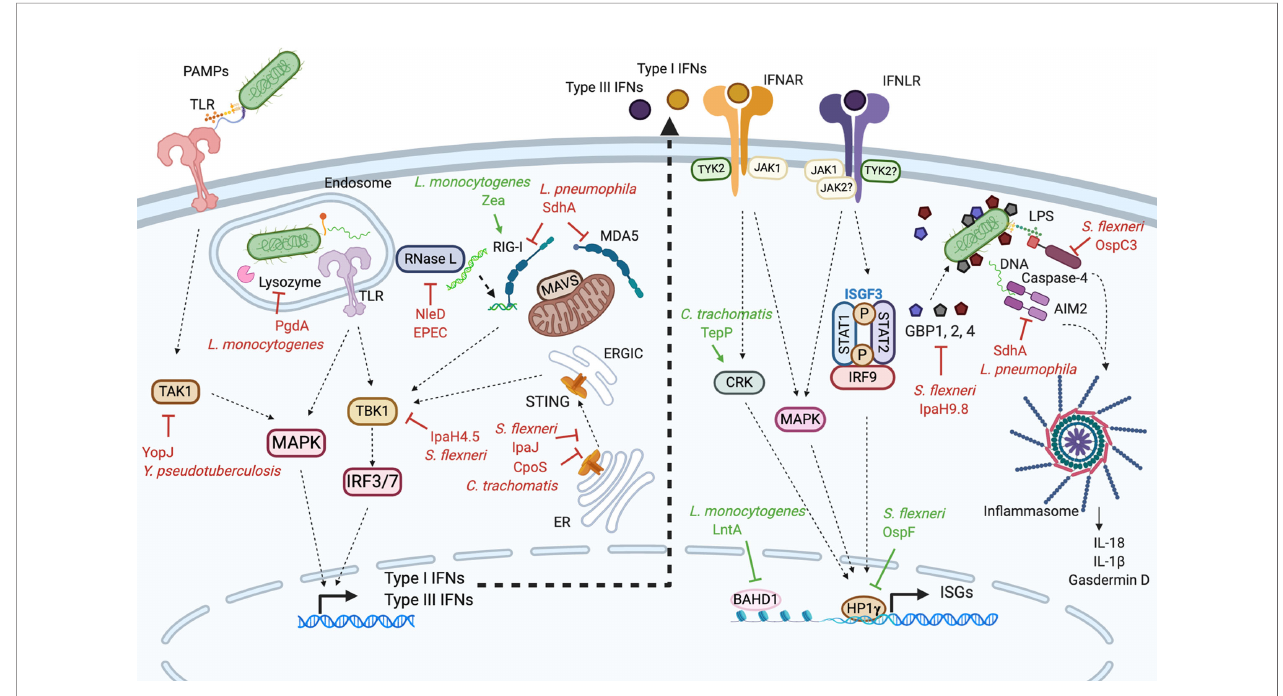
FIGURE 1 | Modulation of types I and III interferon responses by bacterial effectors. In many different cell types, the recognition of bacterial PAMPs by PRRs leads to the production of type I and III IFNs (left side). Type I and III IFNs bind their respective receptors initiating signaling pathways which trigger the expression of ISGs (right side). Bacteria have evolved effectors that either inhibit (depicted in red) or stimulate (depicted in green) type I and III IFN responses. Yersinia pseudotuberculosis YopJ effector interferes with the MAP kinase activator TAK1. When internalized in endosomes, Listeria monocytogenes secretes PgdA which modi fi es its peptidoglycan, hiding it from the host lysozyme. Listeria monocytogenes also secretes Zea which binds RIG-I and potentiates the production of IFNs. The Legionella pneumophila protein SdhA blocks RIG-I and MDA5 cytosolic PRRs preventing them to interact with MAVS. The Shigella fl exneri protease IpaJ interferes with STING translocation to the ERGIC while IpaH4.5 inhibits TBK1 kinase. Similarly, Chlamydia trachomatis CpoS effector affects STING migration. EPEC, through the secretion of NleD inhibits RNase L which counteracts the protective effects of type I IFN on epithelial barriers. Additionally, some bacteria perturb type I and III IFN signaling. L. monocytogenes LntA and S. fl exneri OspF effectors enter the cell nucleus and potentiate ISGs transcription. LntA sequesters BAHD1, a negative regulator of ISGs transcription therefore stimulating ISGs expression. OspF interacts with HP1 g preventing its phosphorylation, which promotes ISGs expression. C. trachomatis TepP effector inhibits CRK, a component and regulators of type I and III IFN signaling, stimulating ISGs transcription. Finally, S. fl exneri IpaH9.8 and OspC3 as well as L. pneumophila SdhA effectors inhibit in fl ammasome components; GBP1, caspase-4, and AIM2 respectively. PRRs, pattern recognition receptors; PAMPs, pathogen-associated molecular patterns; TLR, Toll like receptor; STING, stimulator of interferon genes; ER, endoplasmic reticulum; ERGIC, ER-Golgi intermediate compartments; IRF, interferon regulatory factor; RIG-I, retinoic acid-inducible gene-I; MDA5, melanoma differentiation-associated protein 5; MAVS, mitochondria-antiviral signaling protein; TAK1, TGFbeta activated kinase 1; TYK2, tyrosine kinase 2; JAK1, Janus kinase 1; STAT, signal transducer and activator of transcription; ISGF3, interferon-stimulated gene factor 3; MAPK, mitogen-activated protein kinase; GBP, guanylate-binding protein; AIM2, absent in melanoma-2; LPS, lipopolysaccharide; ISG, interferon stimulated gene; IFNAR, IFN a receptor; IFNLR,IFN l receptor. Figure 1 was created with